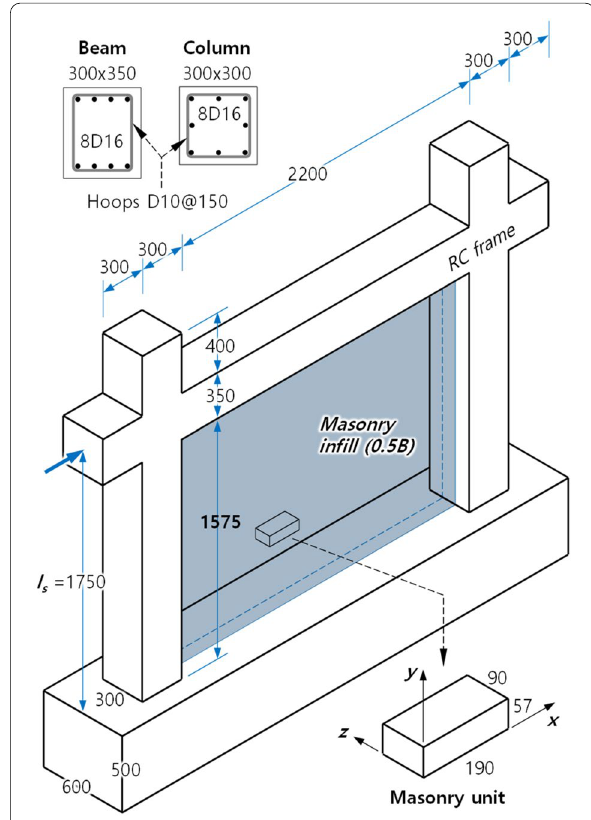
Fig. 4 Reinforced concrete moment frames with and without masonry infill tested by Kim et al.